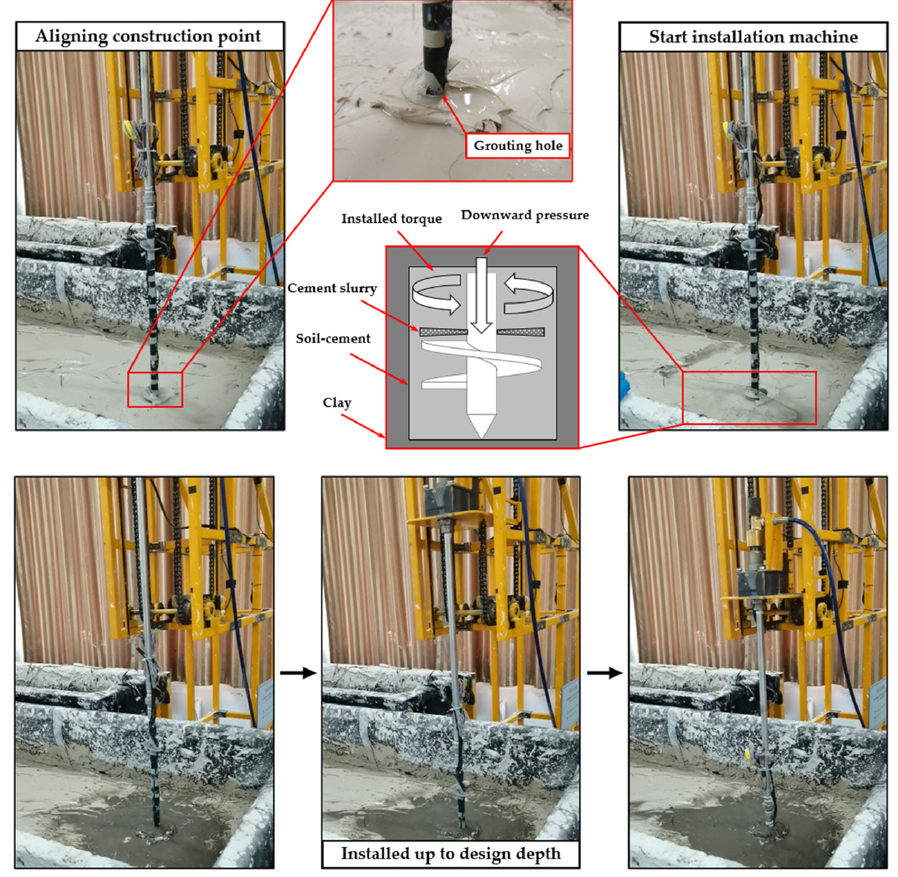
Figure 7. Installation procedure of small-scale pressure-grouted helical piles.